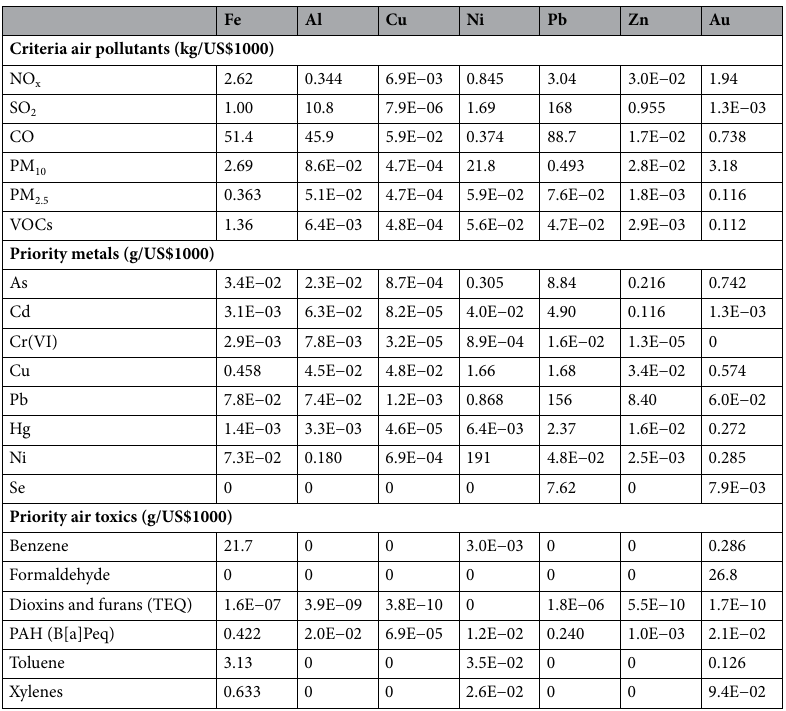
Table 3. Atmospheric emission of criteria and priority atmospheric pollutants expressed on per US$ of metal market